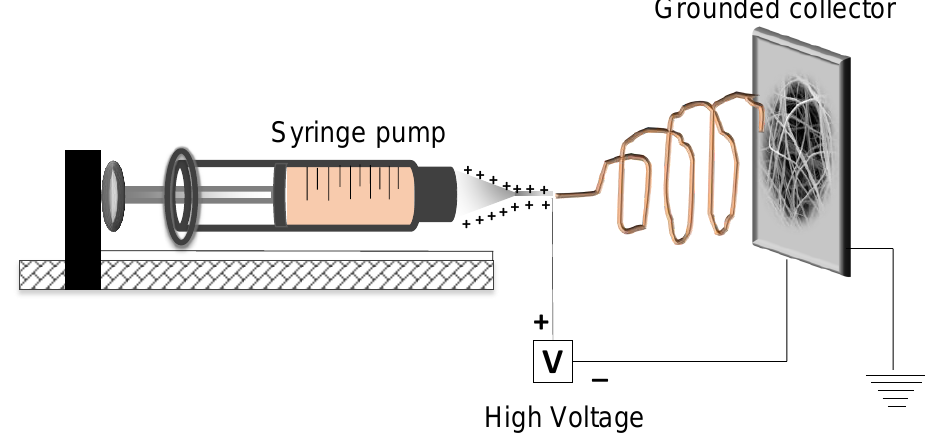
Figure 1. Schematic representation of the electrospinning setup.